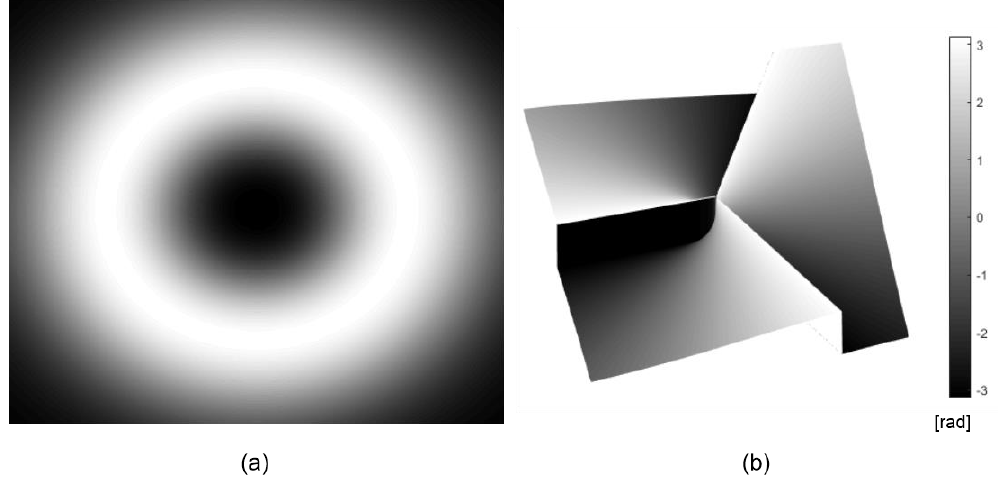
Figure 1. Vortex beam with a topological charge of m = 3: ( a ) intensity, ( b ) phase profile.